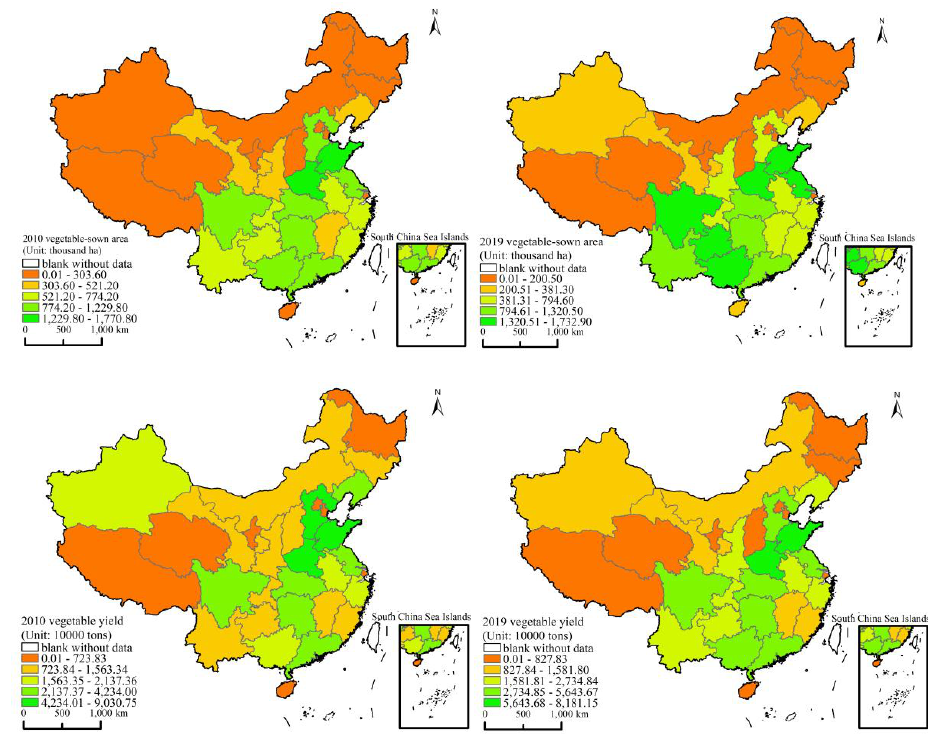
Figure 2. Spatial distribution pattern of vegetable-sown area and yield in